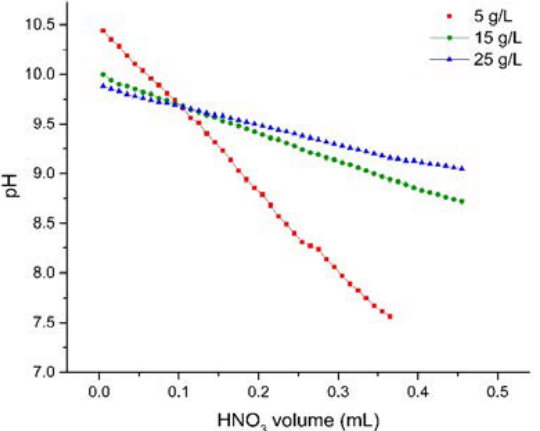
Fig. 8: Potentiometric mass titration curves of am‐Zr/MgFe‐LDH composite samples using 0.1 M HNO 3